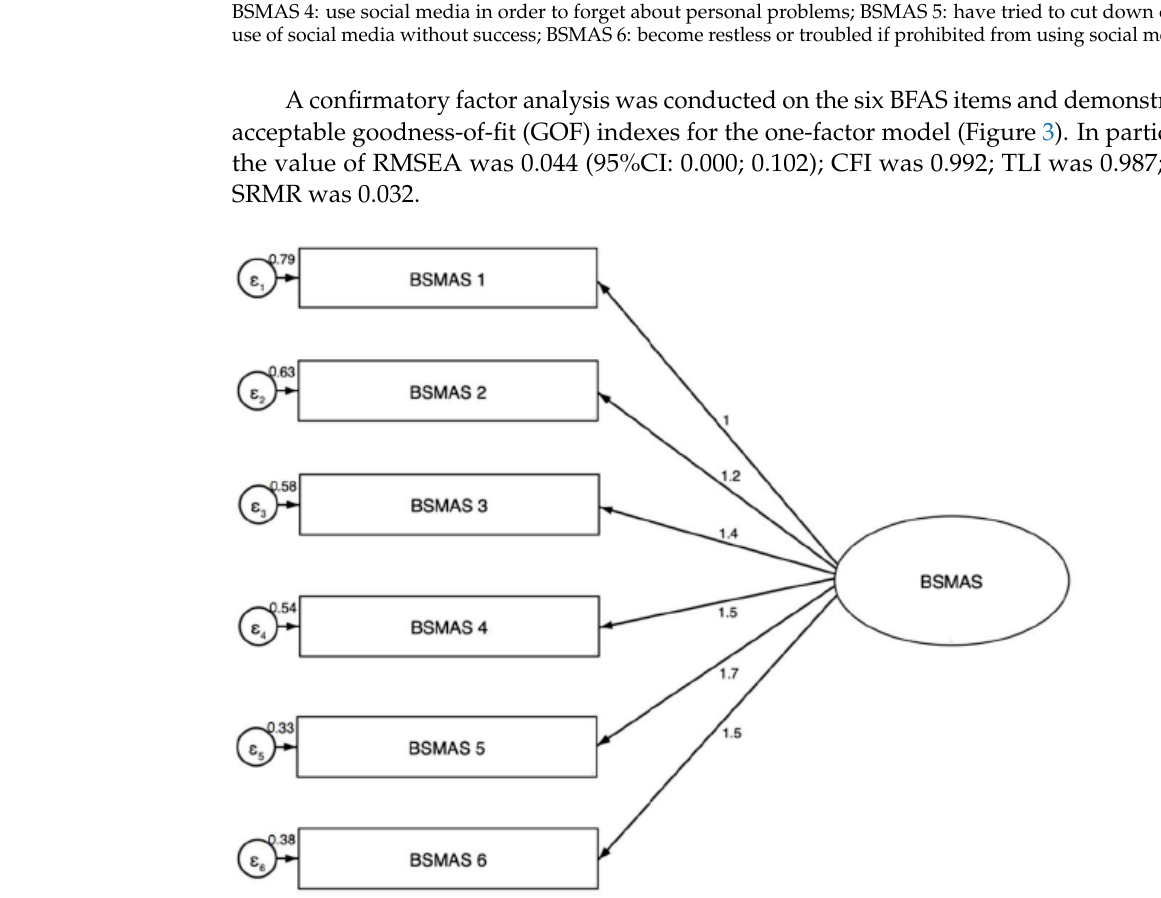
Figure 3. Factor structure and standardized loadings (CFA) of items of Bergen Social